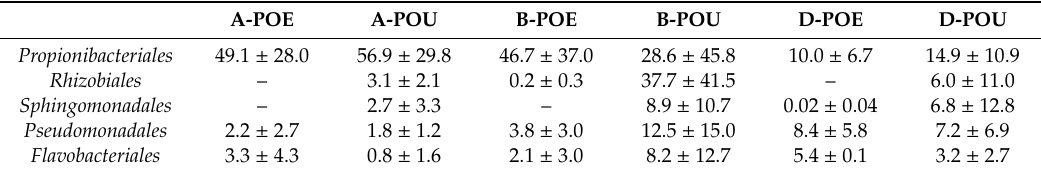
Table 2. The bacterial orders detected in all point-of-use (POU) samples across three sites and their relative abundance in percentage.